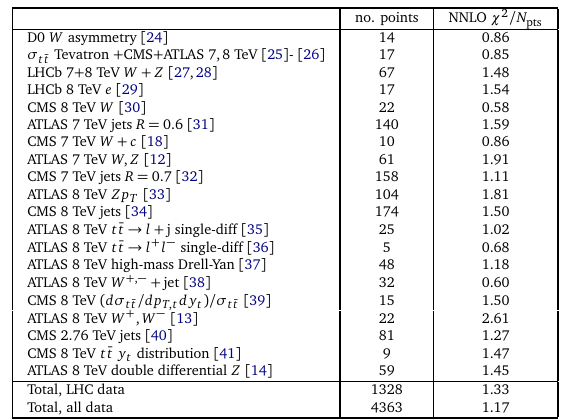
Table 1: The χ 2 for new collider data in the MSHT20